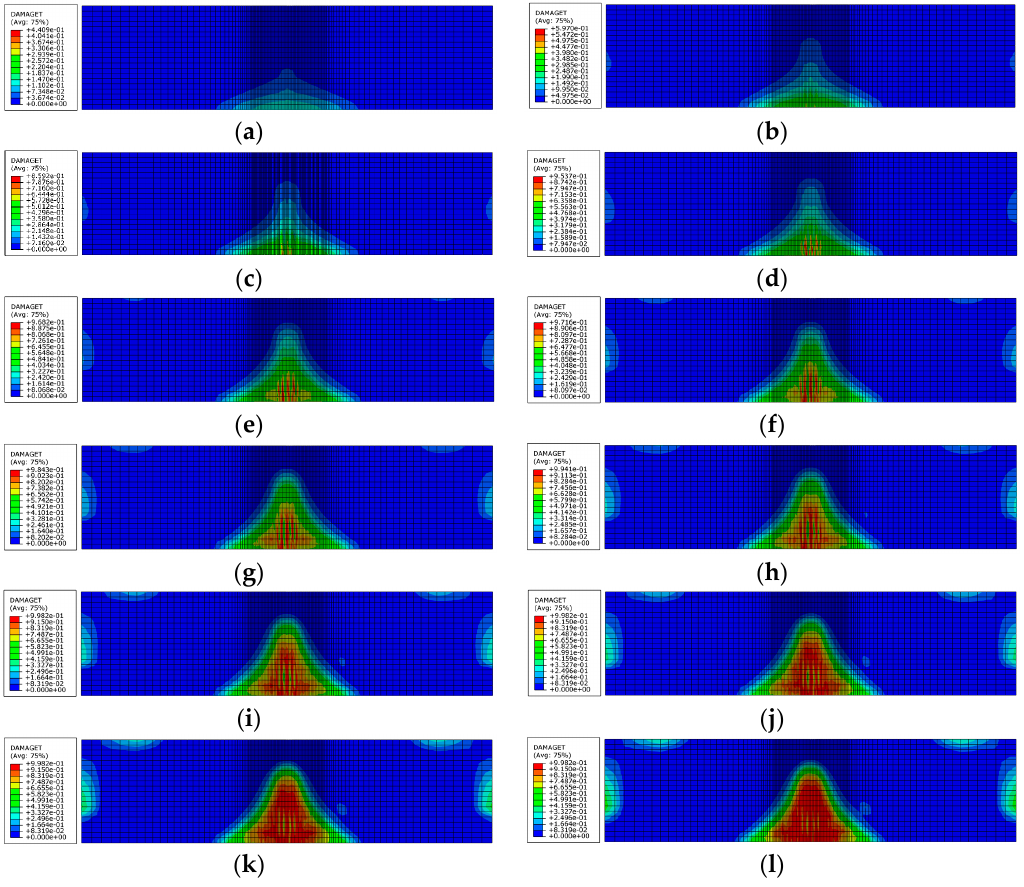
Figure 4. Damage of concrete specimen at different impact times: ( a ) first impact; ( b ) second impact; ( c ) third impact; ( d ) fourth impact; ( e ) fifth impact; ( f ) sixth impact; ( g ) seventh impact; ( h ) eighth impact; ( i ) ninth impact; ( j ) 10th impact; ( k ) 11th impact; and ( l ) 12th impact.